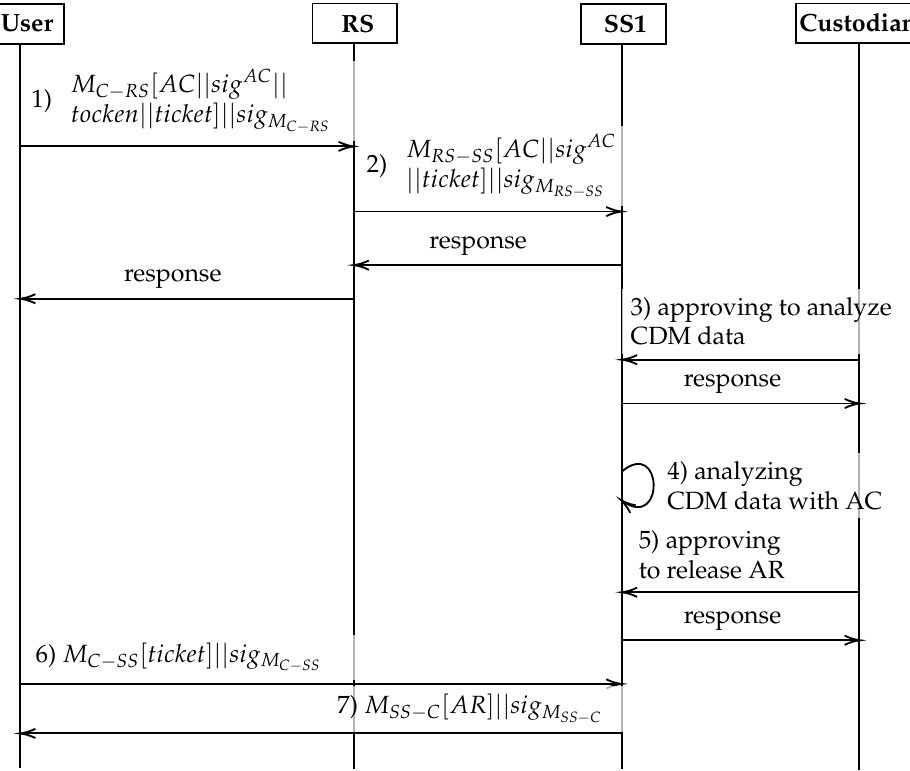
Figure 6. Sequence diagram for distributing AC in intervention